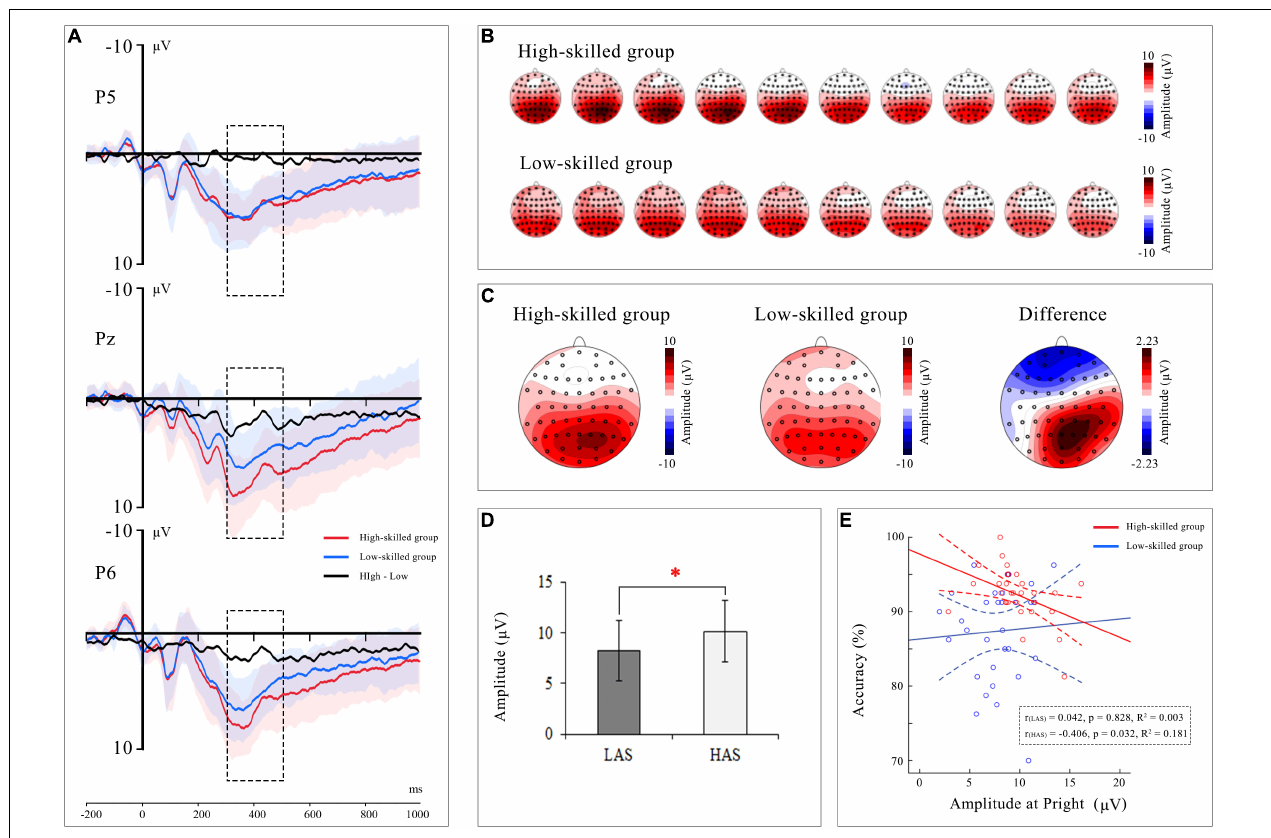
FIGURE 4 | Group-level P3b waveform (highlighting with dashed rectangle) and topographic map in the relative discount. (A) The waveform of group difference at P3, Pz, and P4 electrodes. And the shaded area represents standard deviation. (B) Topographic map of P3b were displayed at the intervals 300 ∼ 500 ms in high-skilled group and low-skilled group. (C) The Grand average P3b topographic maps for two experimental groups and their difference. (D) Amplitude of P3b reflecting a significant difference for two experimental groups. (E) Correlations between P3b amplitude at right parietal area and accuracy. Each colored dot represented raw data of a subject. Full lines represented the best linear fit, and dotted lines represented 95% CI in two experimental